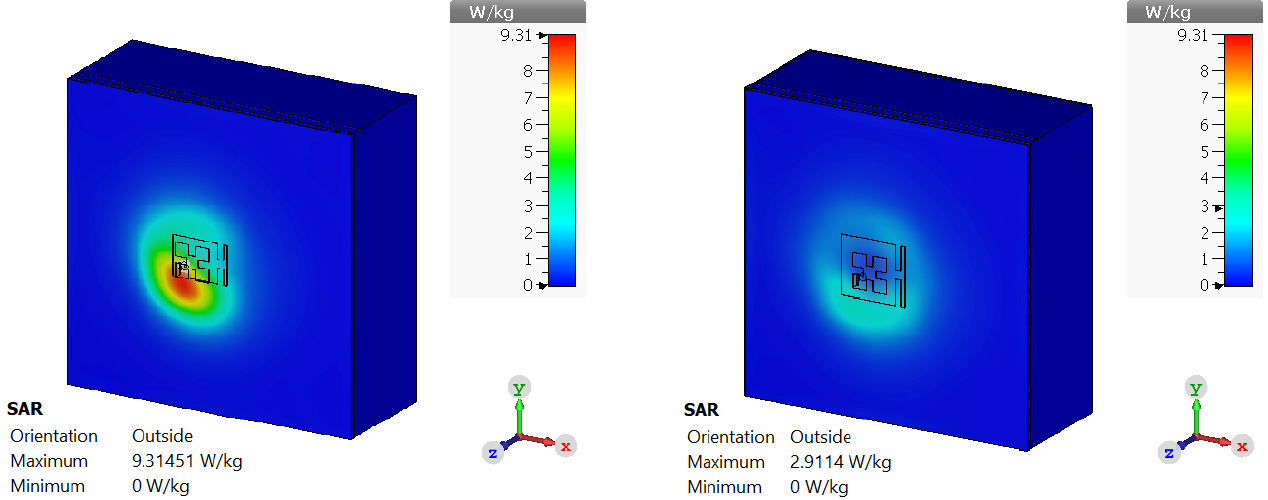
Figure 9. SAR simulation for the Minkowski pre-fractal-shaped PIFA in the presence of human body tissue.